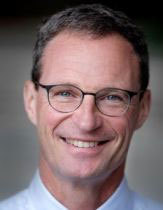
Philippe Demaerel